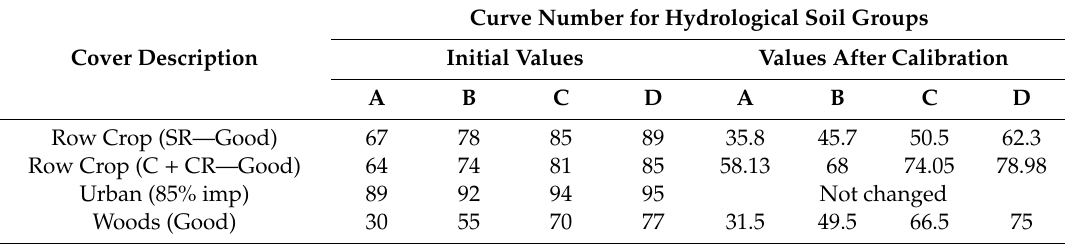
Table 3. Curve Numbers (CN) used for model calibration, Pawcatuck River watershed.